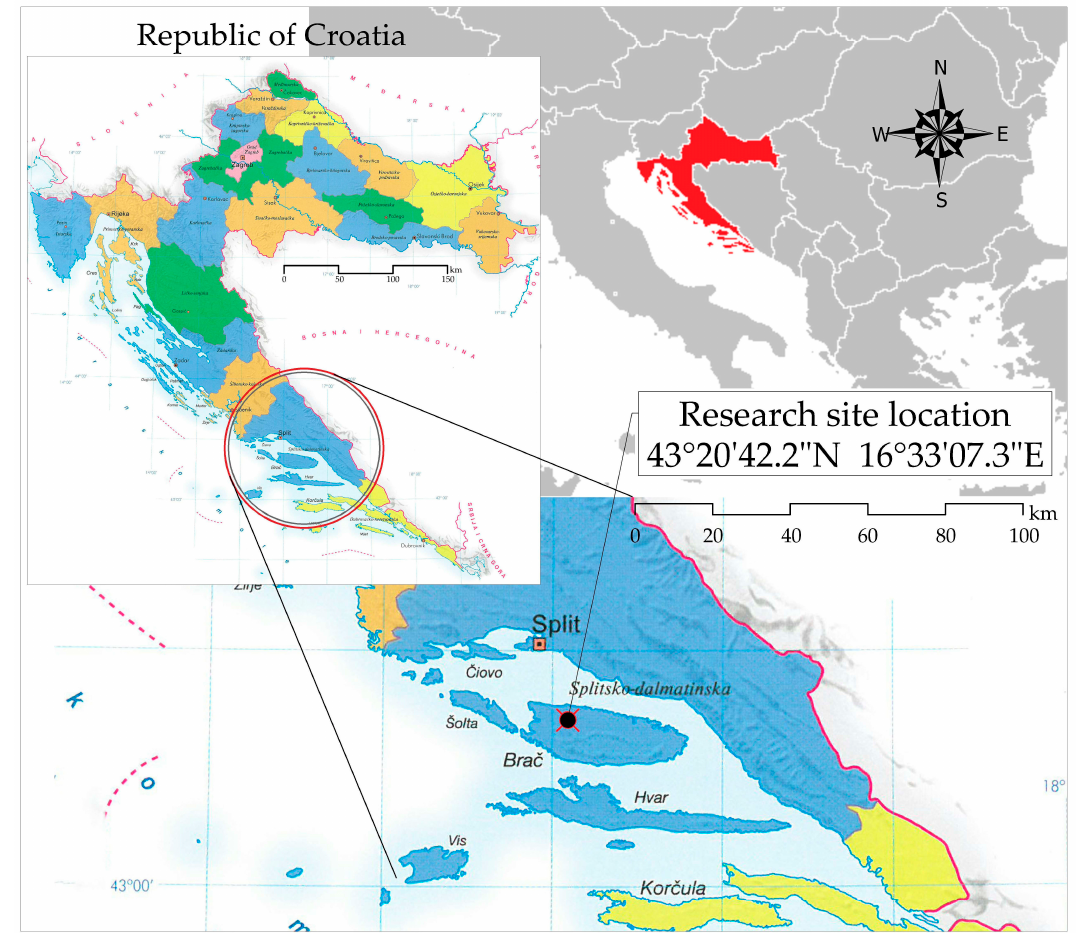
Figure 1. Research site location on the island of Bra č .